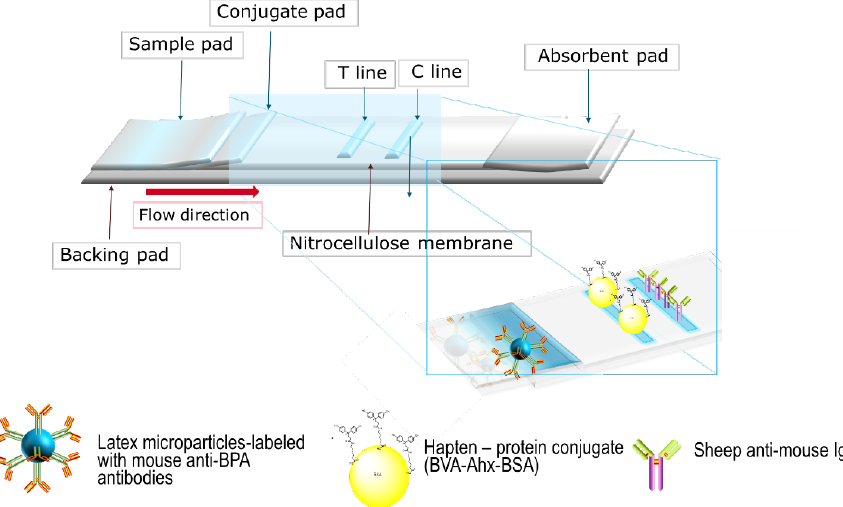
Figure 1. Schematic image of detection of bisphenol A in lateral flow